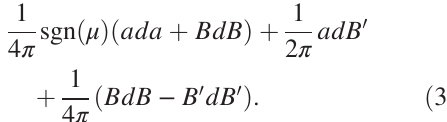
FIG. 1. Mean-field phase diagram for the mass term m 1 j z 1 j 2 þ m 2 j z 2 j 2 in the easy-plane NCCP 1 model. The same phase diagram is obtained from the QED theory with mass term m 1 ¯ ψ 1 ψ 1 − m 2 ¯ ψ 2 ψ 2 . The upper panel is realized in the context of the quantum magnet, where the U ð 1 Þ symmetry is only B 2 emergent. The lower panel is realized in the context of the integer quantum Hall transition of bosons, where the two superfluid phases correspond to superfluids of the first or second layer, i.e., up or down components of the pseudospin. (Going beyond mean field will move the phase boundaries away from the